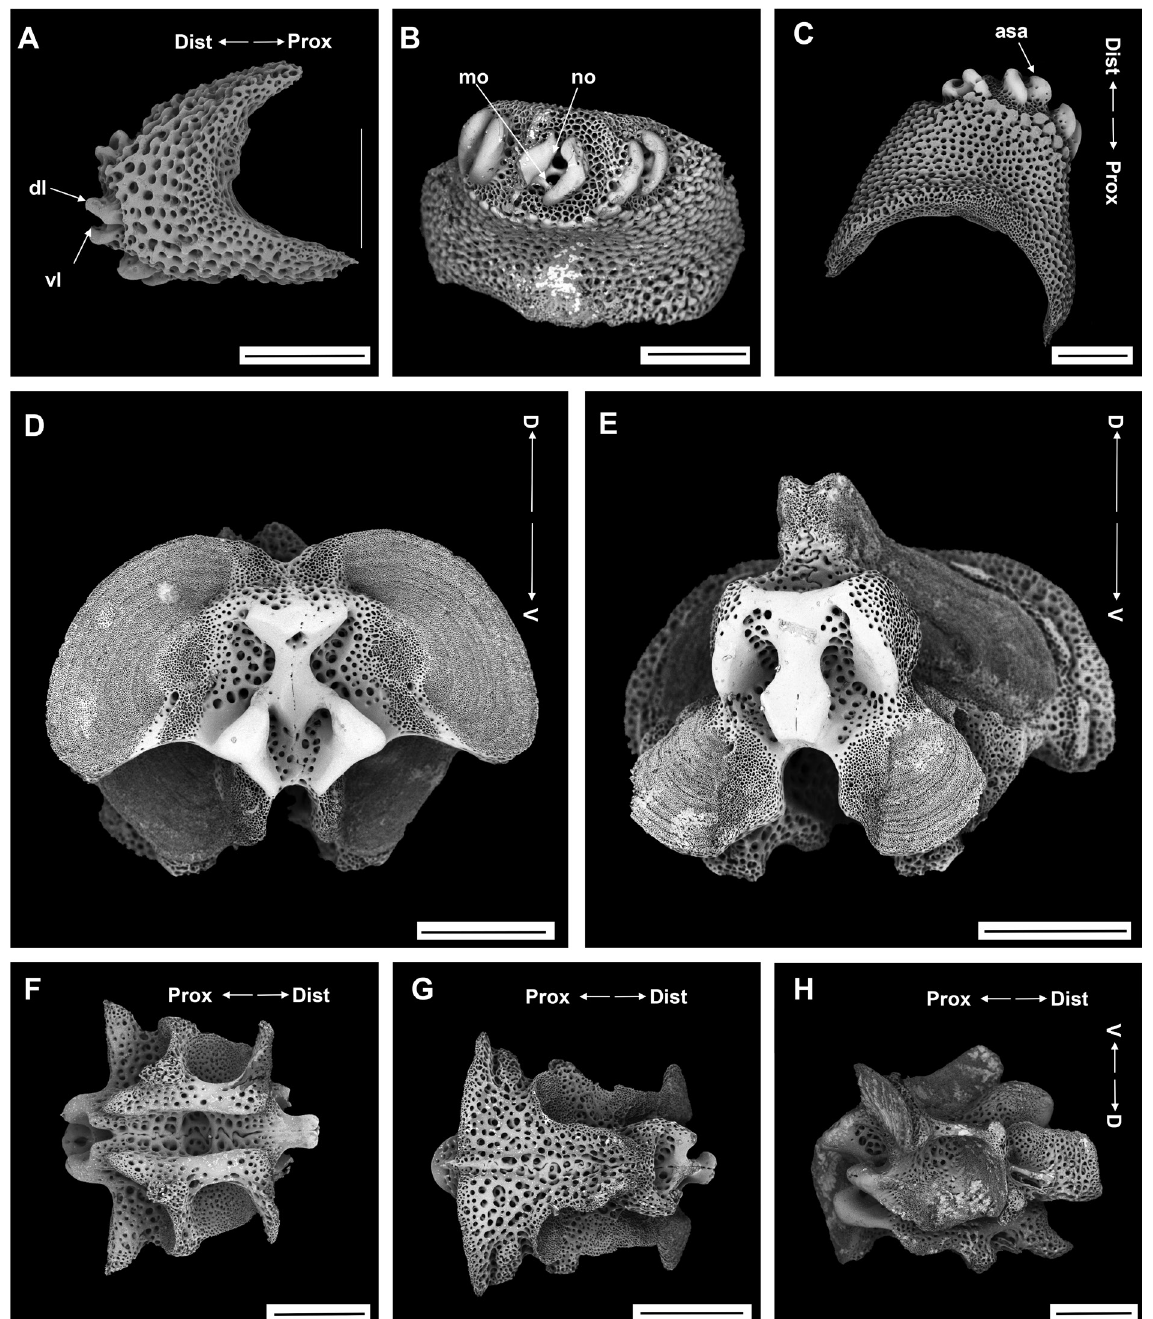
Fig. 37. Ophiactis cf. perplexa Koehler, 1897, SEM (IDSSE EEB-SW0013). A–C . Lateral arm plate. D–H . Vertebrae. D . Proximal view. E . Distal view. F . Ventral view. G . Dorsal view. H . Lateral view. Abbreviations: asa = arm spine articulation; D = dorsal; Dist = distal; dl = dorsal lobe; mo = muscle opening; no = nerve opening; Prox = proximal; V = ventral; vl = ventral lobe. Scale bars: A, G = 200 µm; B–F, H = 300